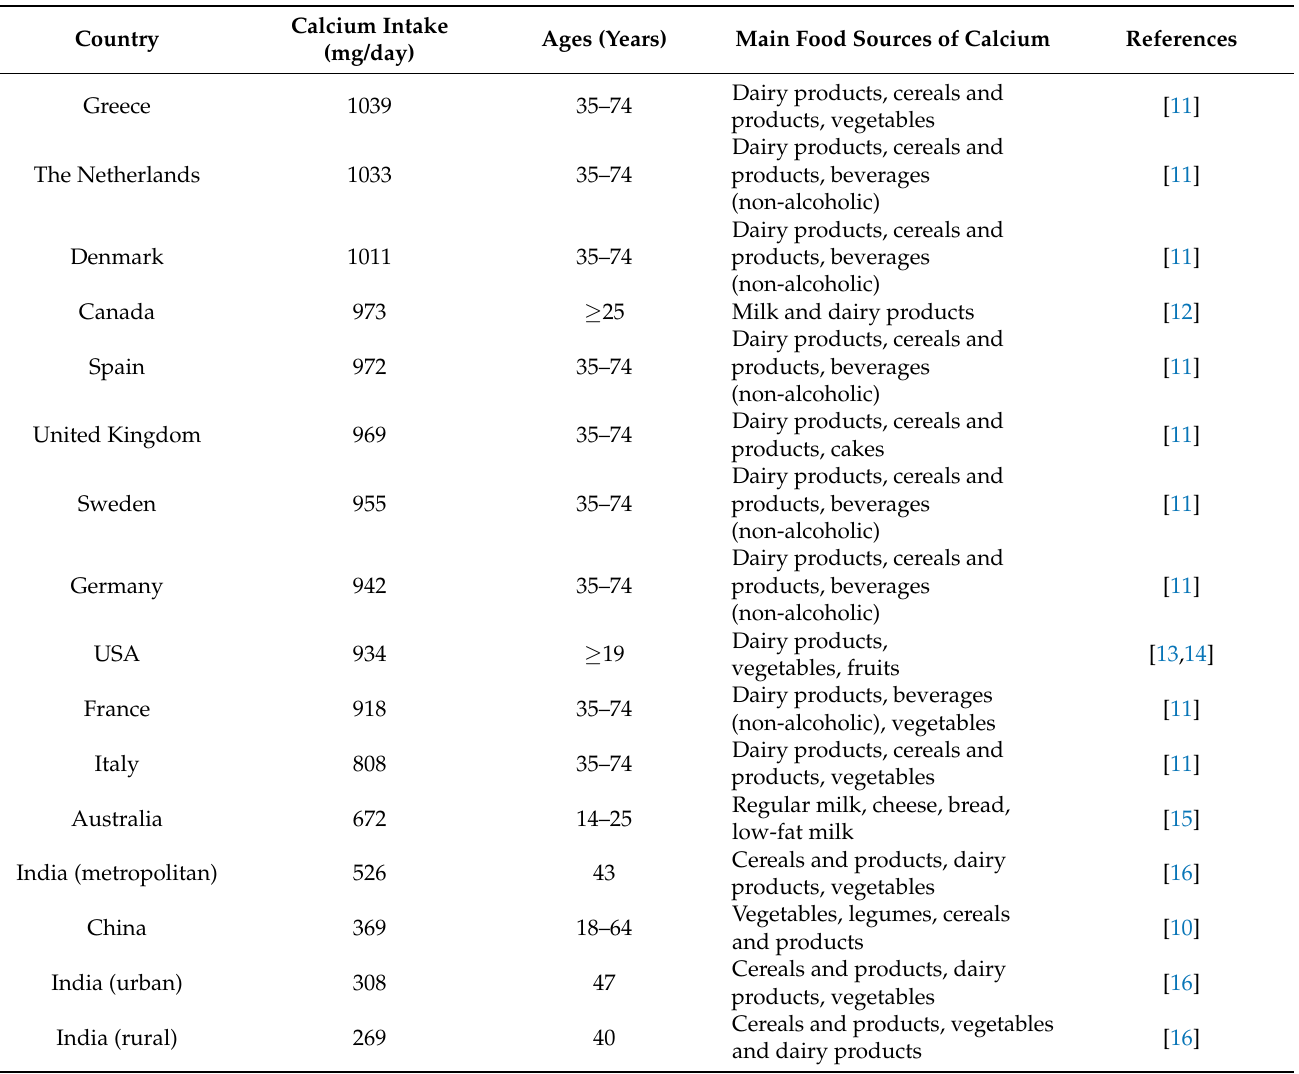
Table 1. Average daily calcium intake for adults and the main dietary sources of calcium in differ- ent